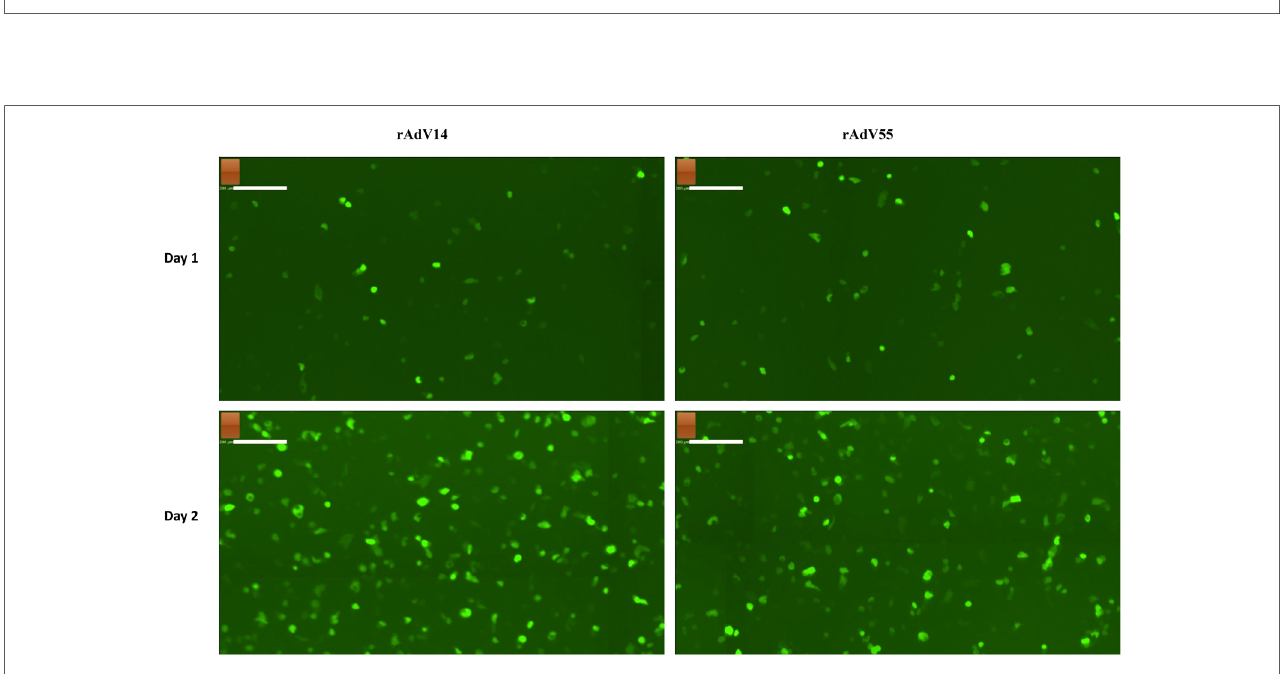
FIGURE 6 Detection of luciferase activity in the supernatant of AD293 cells following transfection with the linearized rAdV14 or rAdV55 genomes. Forty microliters of cell culture supernatant were collected at days 0, 1, 3, 5, 7 and 10 post transfection to measure the luciferase activity. See the legends for Figures 4 , 5 for a description of the treatment of the cells.